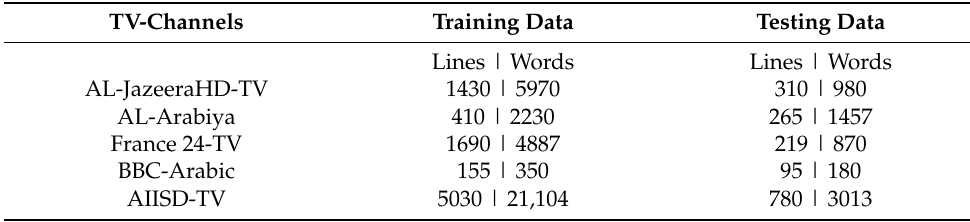
Table 2. Statistical detail of ALIF dataset.